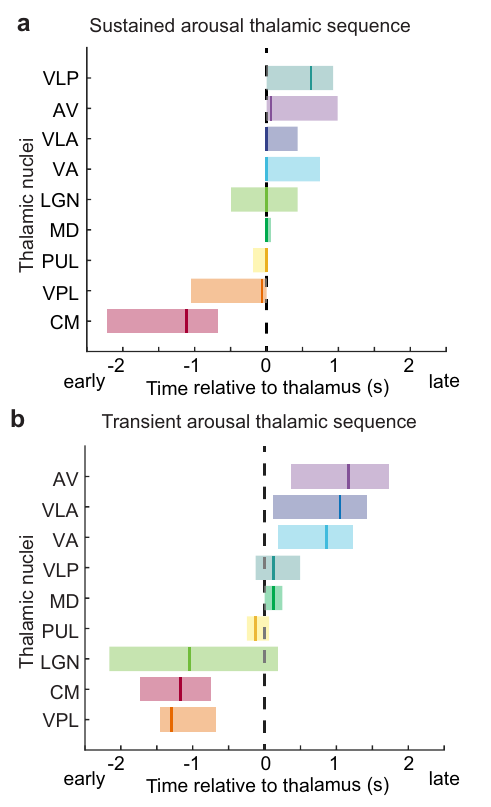
Fig. 7| Sequenceofthalamicactivityinsustained andtransientarousals. a The sequenceatsustained arousals demonstrated thatCMwasstill the fi rst to activate, and the subsequent sequence across nuclei occurs closely together in time. The verticallineisthemeanlag,shadingisa95%con fi denceinterval. b Thesequenceat transient arousals evolved more slowly across nuclei. Source data are provided in the “ Fig. 7 Source Data ” fi